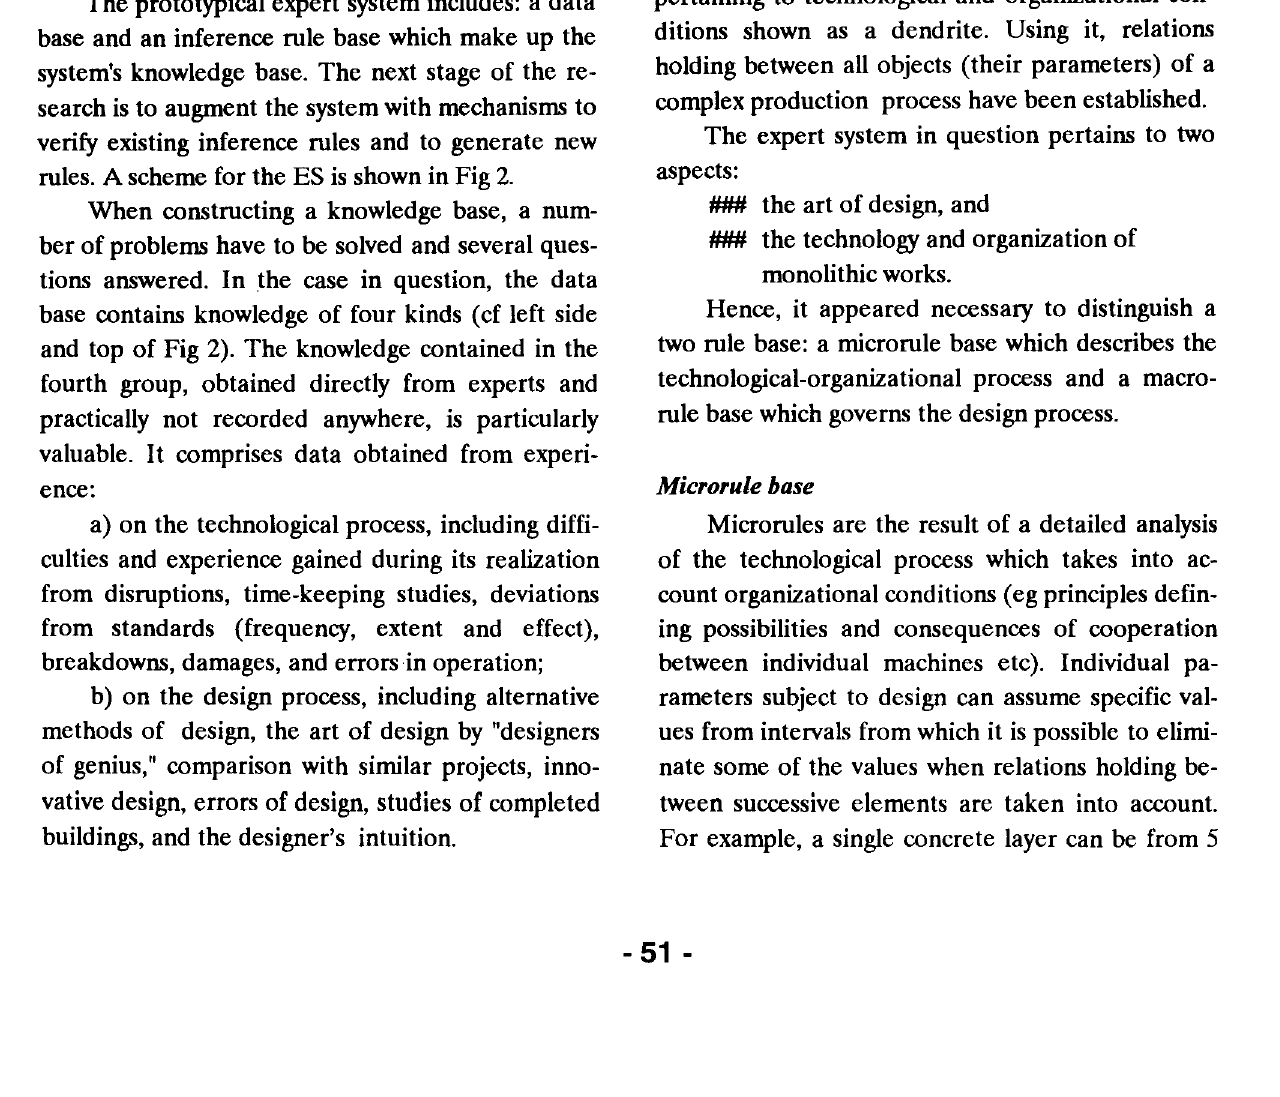
Fig 2. The basic structure of a prototype expert